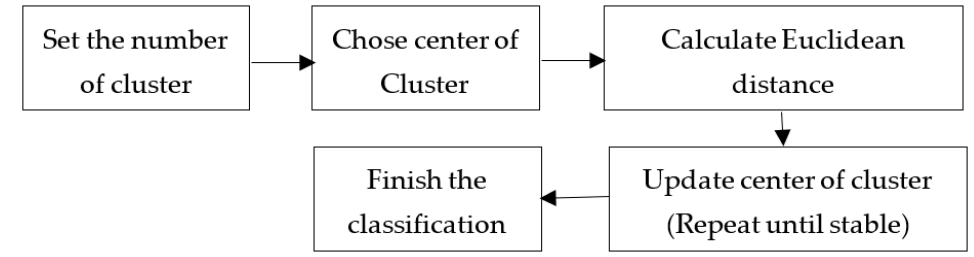
Figure 4. K-means grouping step diagram.